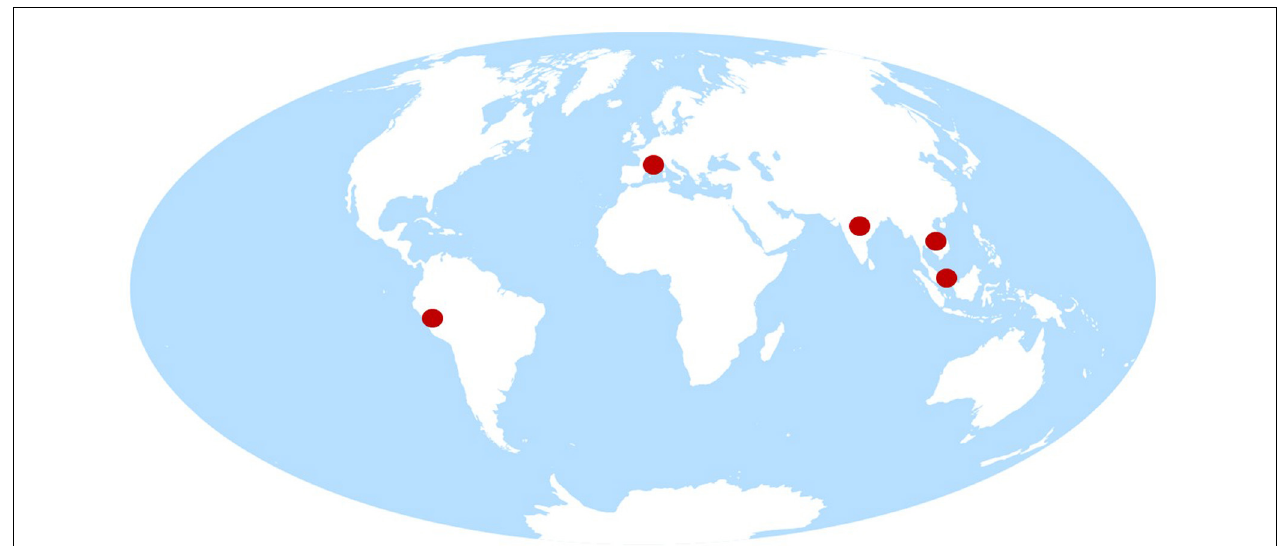
FIGURE 1 | Locations of the five “Experiences in the